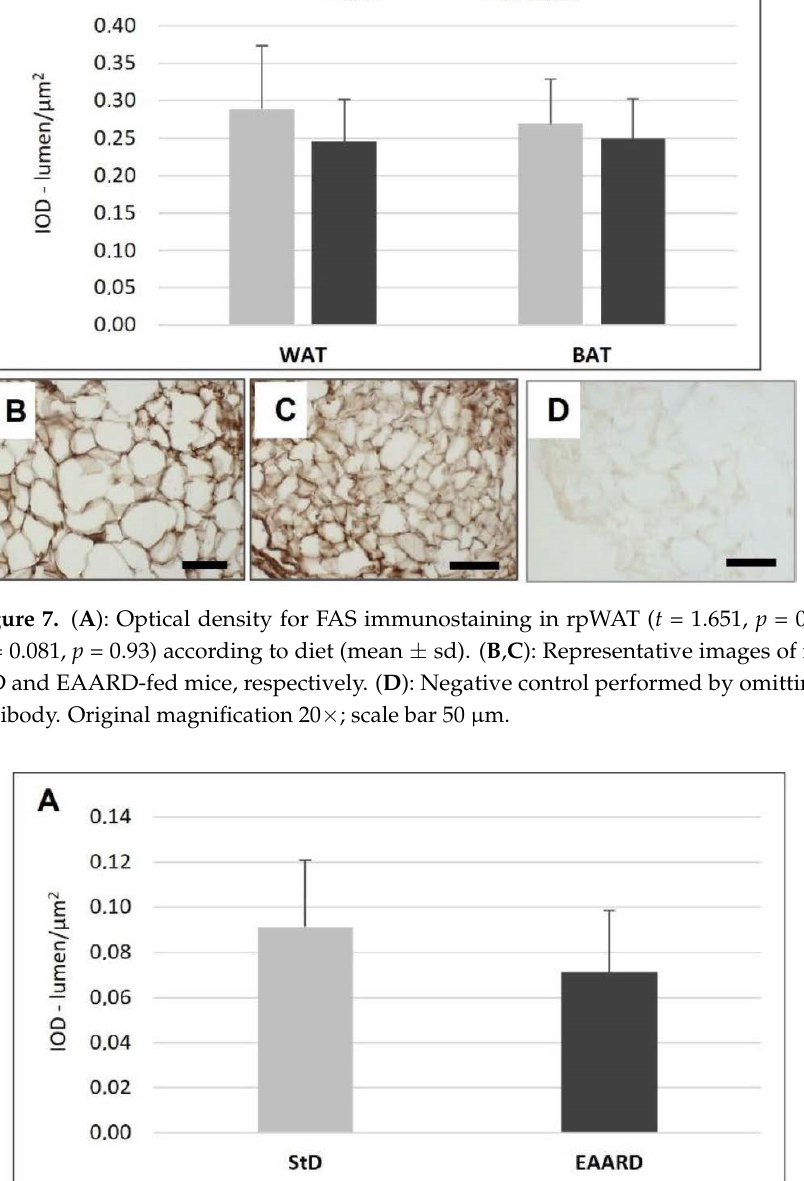
Figure 6. ( A ): Optical density for IL-10 immunostaining in rpWAT ( t = 1.068, p = 0.571) and BAT ( t = 1.615, p = 0.212) according to diet (mean ± sd). Representative images of rpWAT ( B , C ) and BAT ( E,F ) IHC in StD and EAARD-fed mice, respectively. ( D , G ): Negative control performed by omitting the primary antibody. Original magnification 20×; scale bar 100 μm.